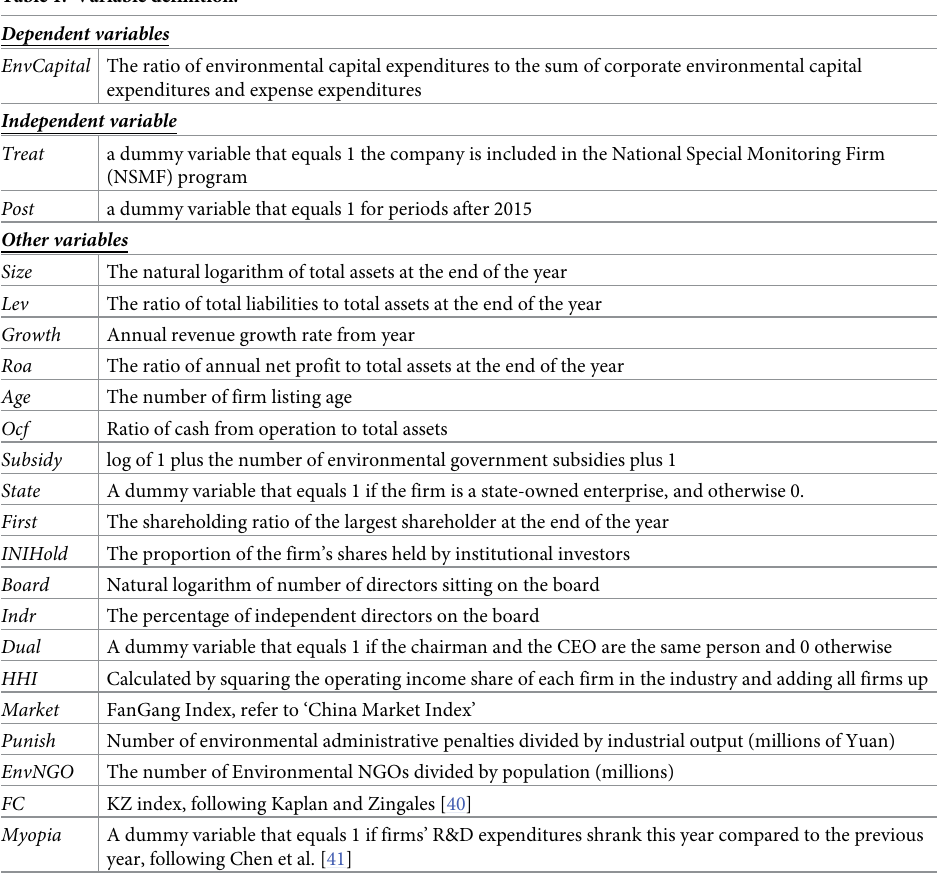
Table 1. Variable